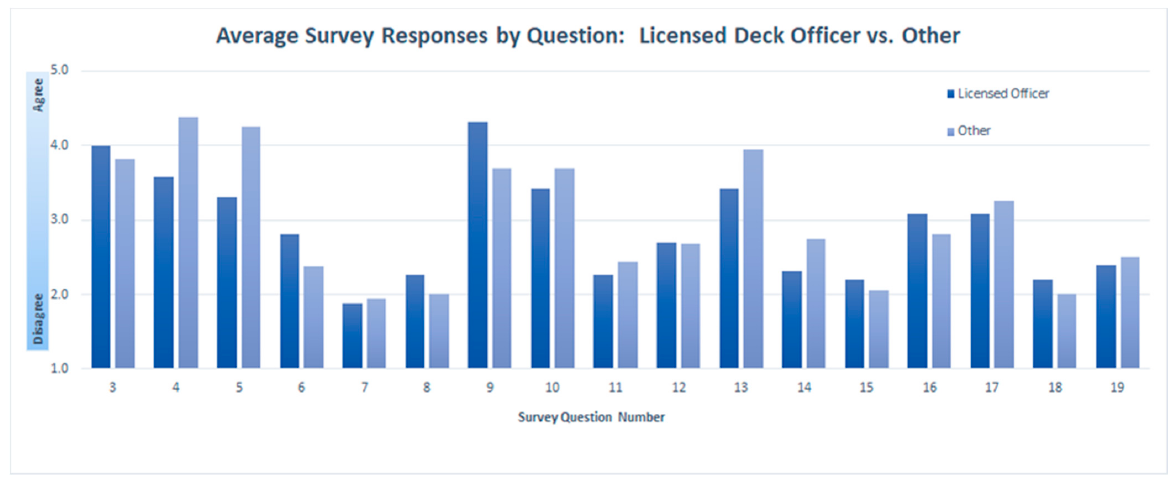
Figure 1. Comparing ‘Licensed Deck Officer’ survey responses vs. ‘Other’ survey responses.